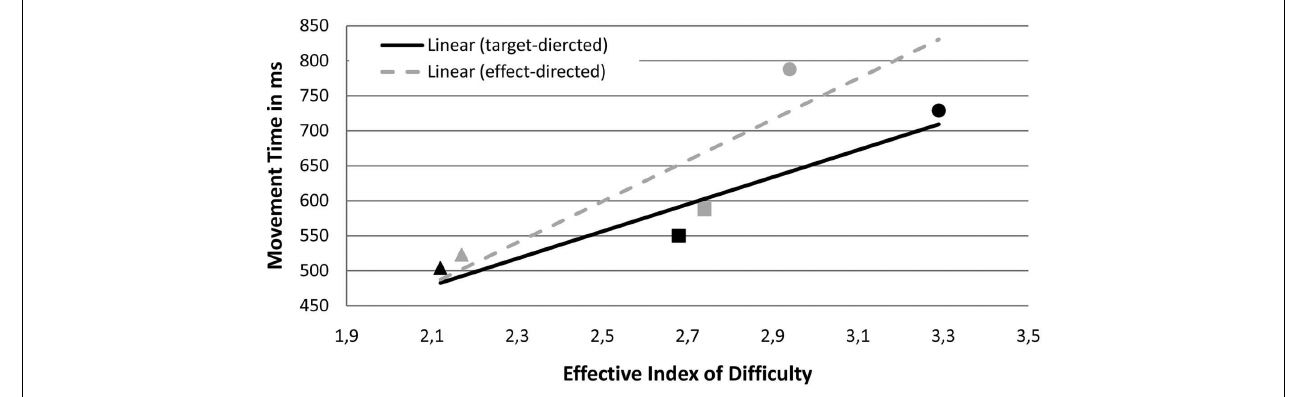
FIGURE 4 | Experiment 1: means and linear functions of the relation between effective Index of difficulty (eID) and movement time (MT in ms) for target-directed and effect-directed movements toward the manipulated goal. Triangles symbolize the one goal constellation, squares the same goals constellation, and circles the different goals constellation. Black markers indicate target conditions, gray markers indicate effect conditions.